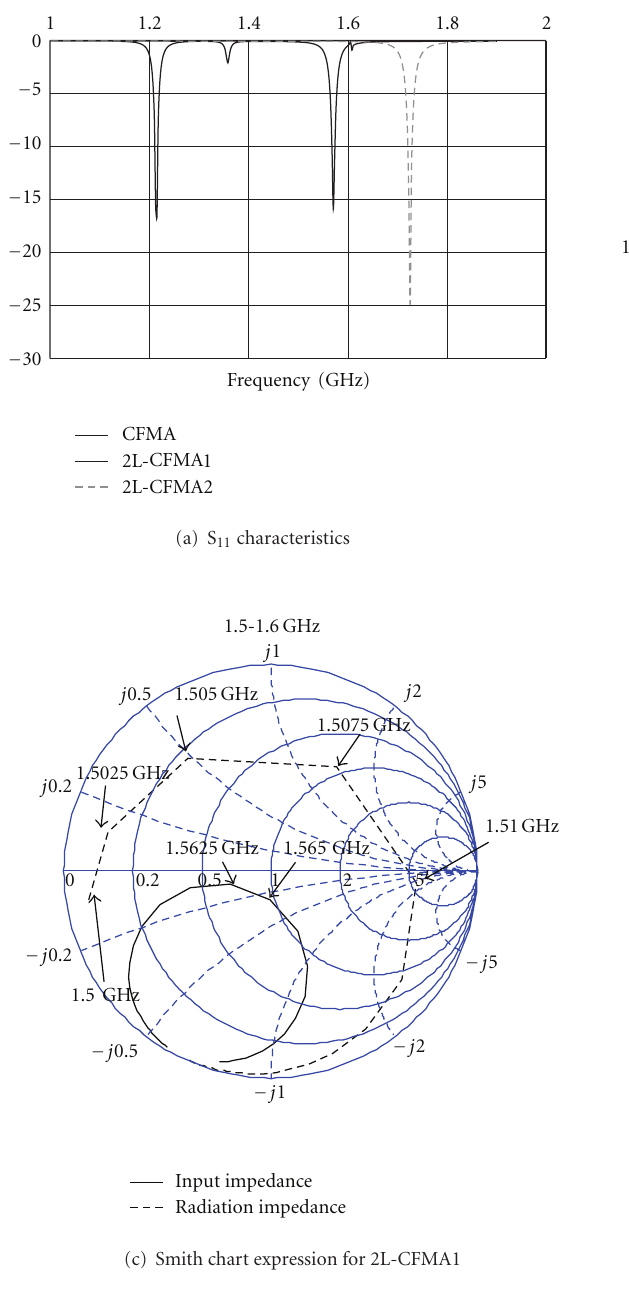
Figure 5: Simulated input characteristics: (a) S11 characteristics, (b) Smith chart expression for CFMA, (c) Smith chart expression for 2L-CFMA1, and (d) Smith chart expression for